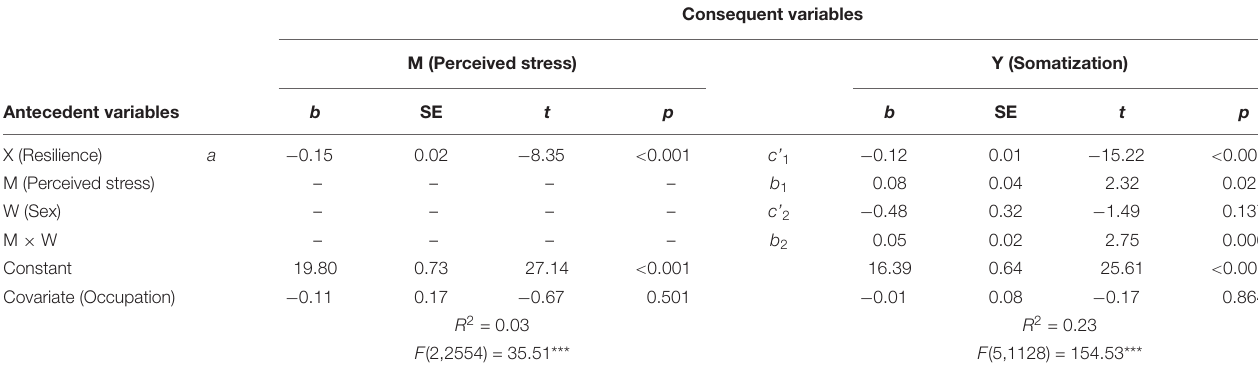
TABLE 3 | Model coefficients for the conditional process